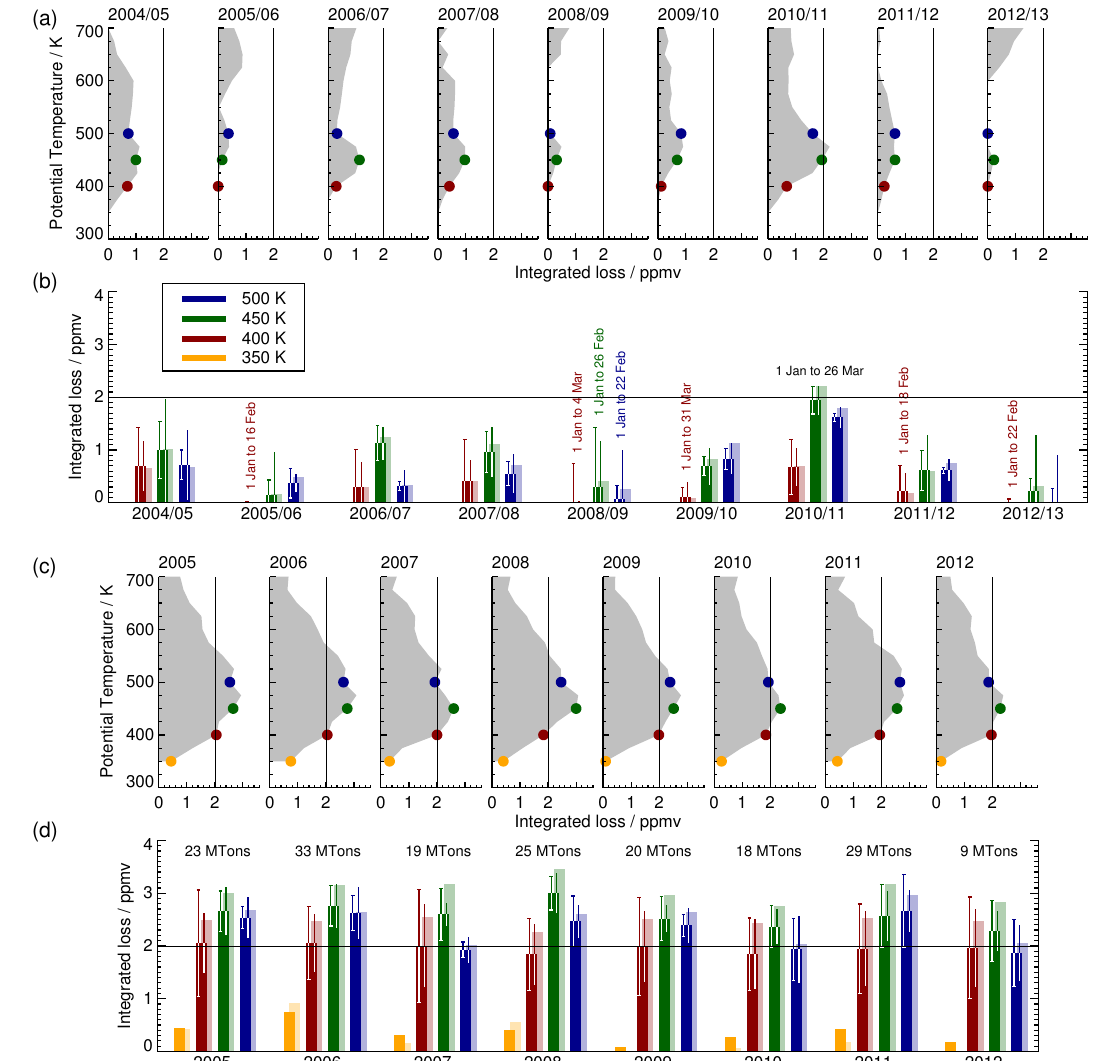
Figure 6. Integrated ozone loss for each Arctic winter from 1 January to 1 April each year for 2004/05 to 2012/13 ( a and b ) and Antarctic winter from 1 June to 15 October for 2005 to 2012 ( c and d ). Occasional shorter periods in the Arctic, owing to vortex breakdown at some altitudes and a March 2011 MLS instrument anomaly, are noted in (b) . (a) and (c) show vertical profiles of ozone loss (grey shading) each season. Colored points highlight the altitudes shown in the bar charts in (b) and (d) . Results shown in strong colors in (b) and (d) are for the “standard” match criteria, with paler colors showing results from the “stricter” calculation (sPV variability < 10 vs. 25%). Error bars on the standard results are N 2 O-based estimates of contributions from transport errors using the “mixing” (left hand error bars with horizontal caps) and “descent” assumptions (right hand error bars), respectively. These are omitted for the 350K (orange) bars in (d) as this altitude is typically below the level at which MLS N 2 O data are scientifically useful. (d) also includes the October-average “ozone mass deficit” (taken from the “Ozone Watch” website,